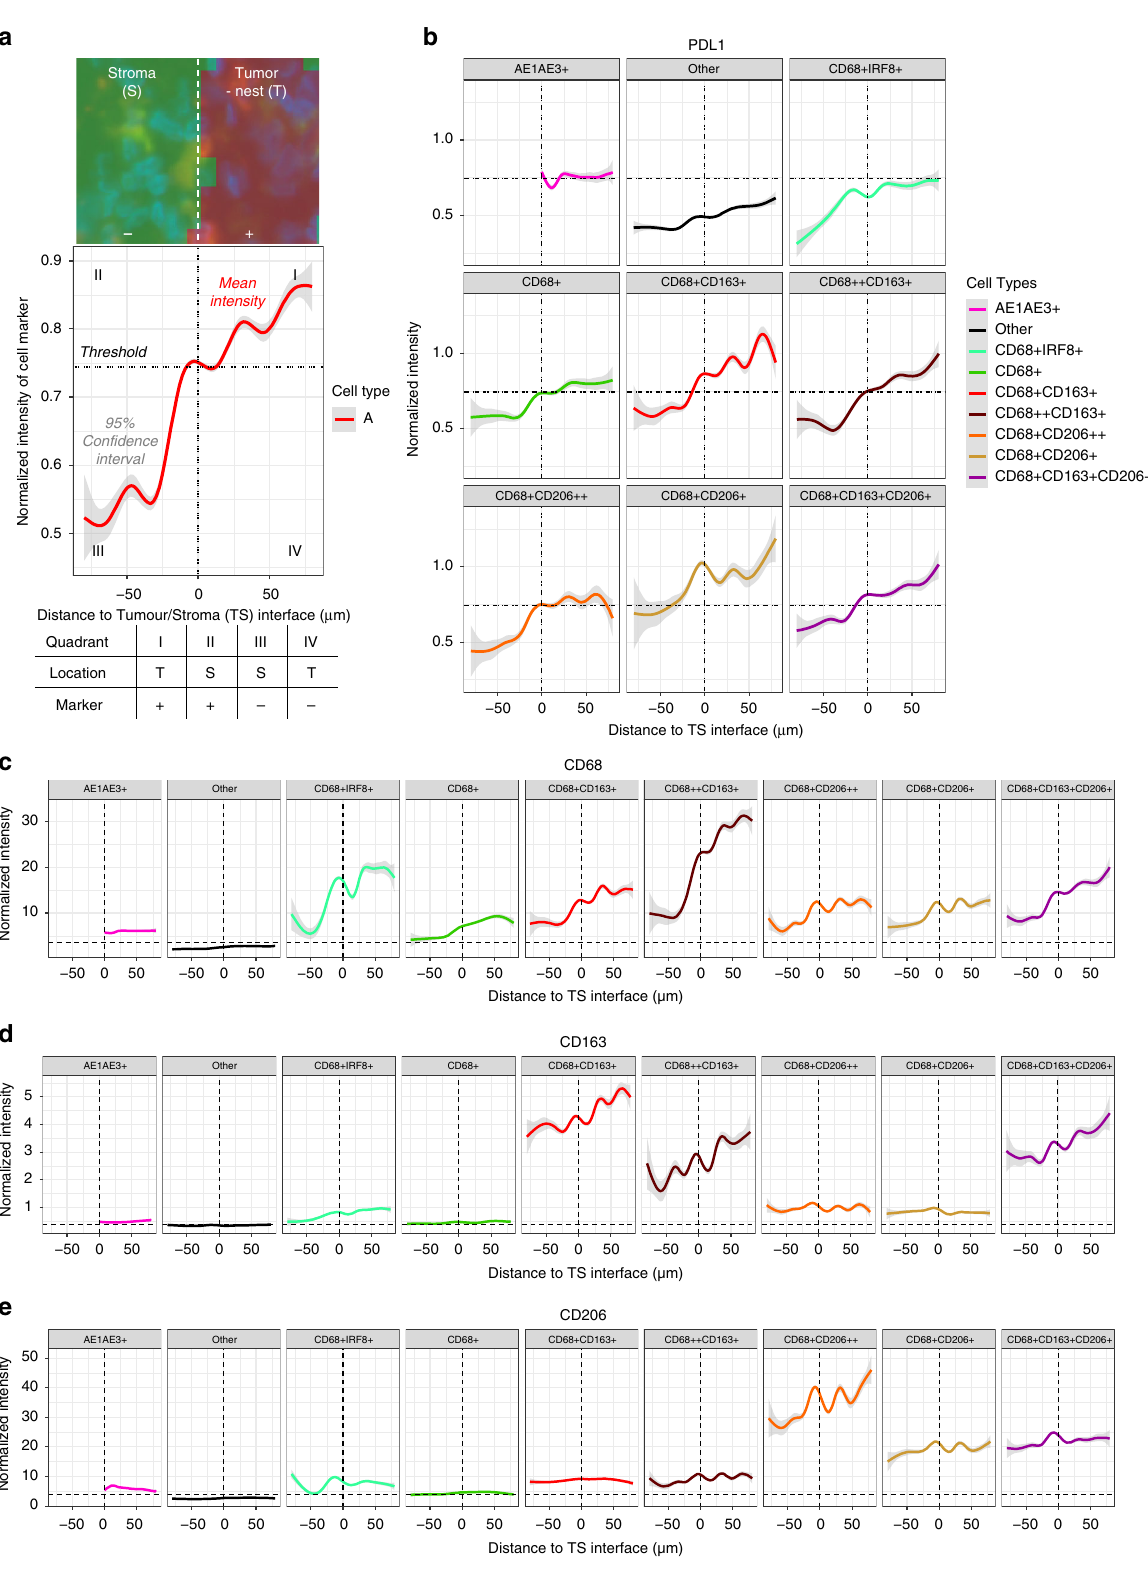
population-speci fi c environmental gene signatures and pathways that provide some information on the in fl uence of the micro- environment on these TAM populations and their putative functions (Fig. 7).